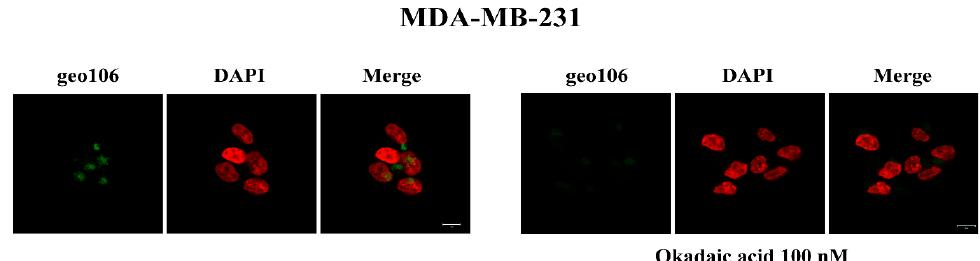
Figure 7. Confocal microscopy images of MCF7 and MDA-MB- 231 cells after incubation with 5 μМ of geo106 for 2, 24 and 48 h, respectively. Cells were fixed with 4% paraformaldehyde. DNA was stained with DAPI (pseudo color red). Cells were visualized with a Zeiss LSM 780 confocal micro- scope using the Zen 2011 software.